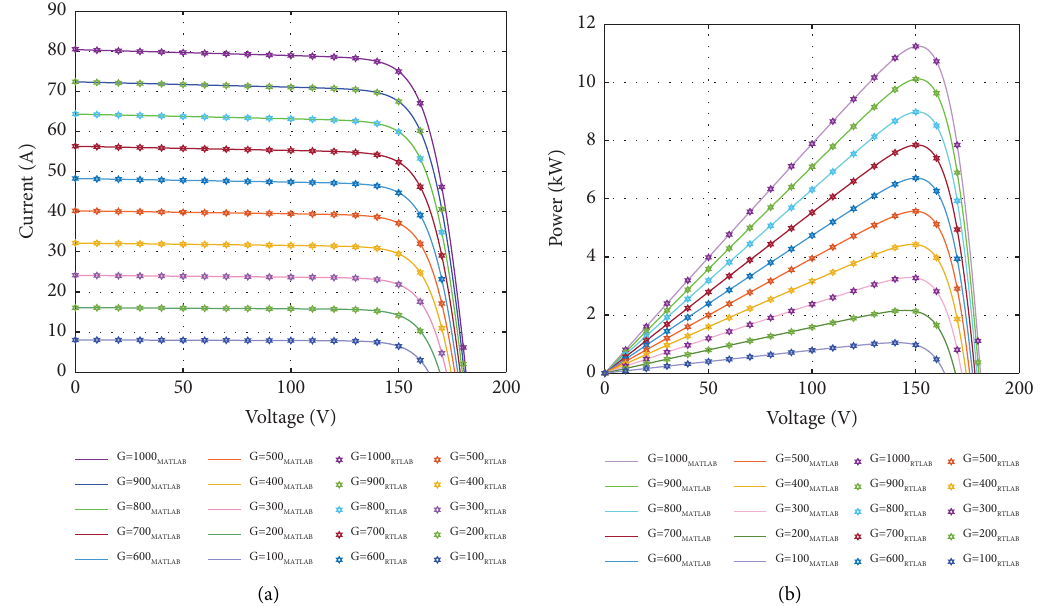
Figure 10: Output characteristic of each PV array obtained by RTLAB and MATLAB platforms under diferent irradiations when T � 25 ° C: (a) I - U curves and (b) P - U